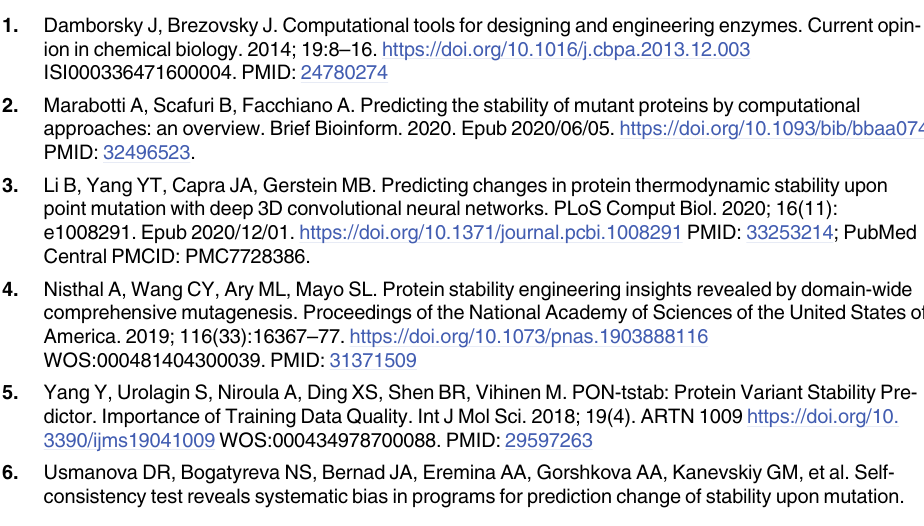
S2 Fig. ROC curves and their AUCs of ΔΔ G